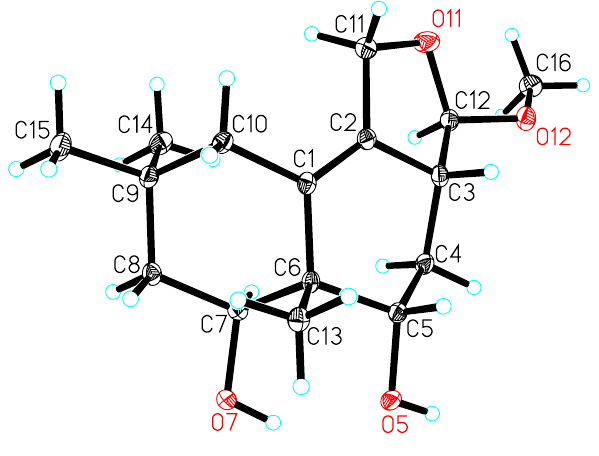
Fig. 3 ORTEP drawing of compound